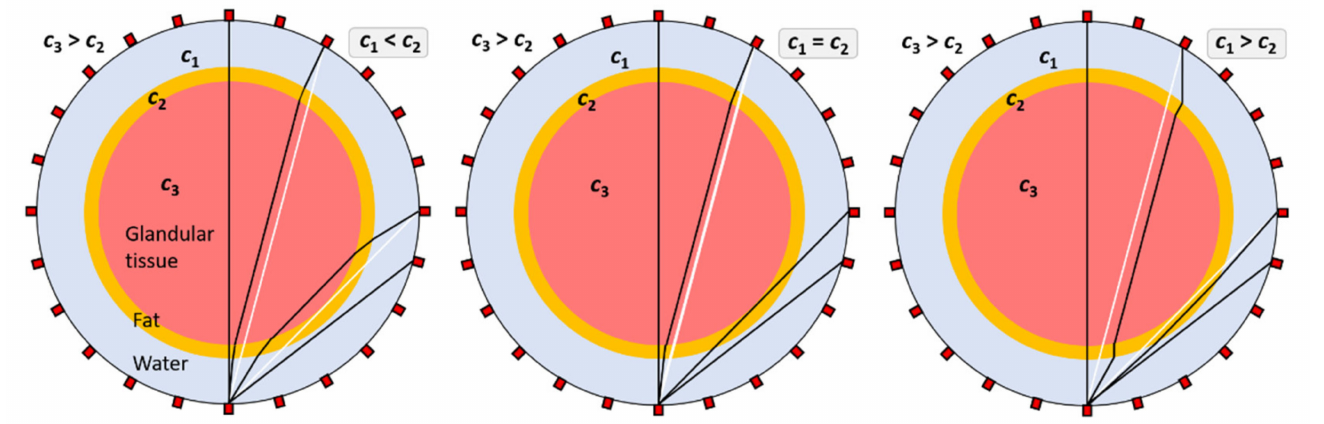
Figure 5. Three different scenarios for the passage of ultrasound beam rays in divergent geometry from the transmitter to four different receivers of a multi-element ultrasound ring array through a breast with a subcutaneous fat layer, immersed in